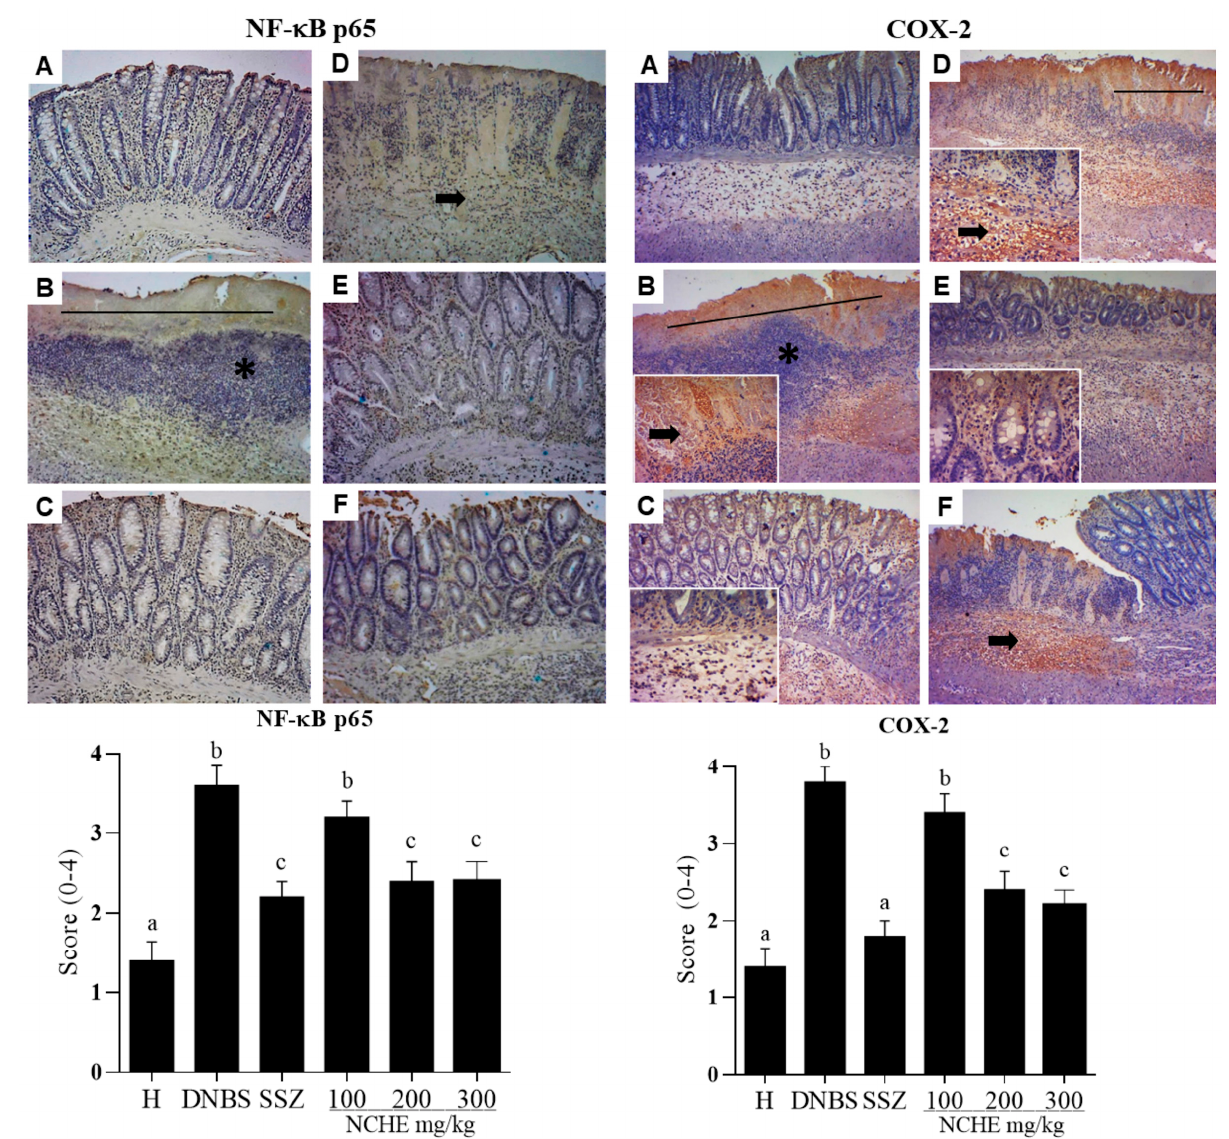
Figure 8. Immunohistochemical analyses of representative colonic tissue (longitudinal section). NF- κ B p65 and COX-2 and their respective immunohistochemical scores. Groups represented: H—healthy group ( A ), DNBS—DNBS control ( B ), Sulfasalazine (SSZ) (250 mg/kg) ( C ) and NCHE— N. cochenillifera hydroethanolic extract (100, 200 and 300 mg/kg) ( D – F ). The figure represents a microscopic damage assessment (10 × and 40 × magnification), the lines indicate diffuse active colitis with intense antibody reactivity, the asterisks represent dense infiltrate of inflammatory cells and arrows indicate antibody reactivity. Data are expressed as means ± SEM. Groups with a different letter differ statistically ( p < 0.05).